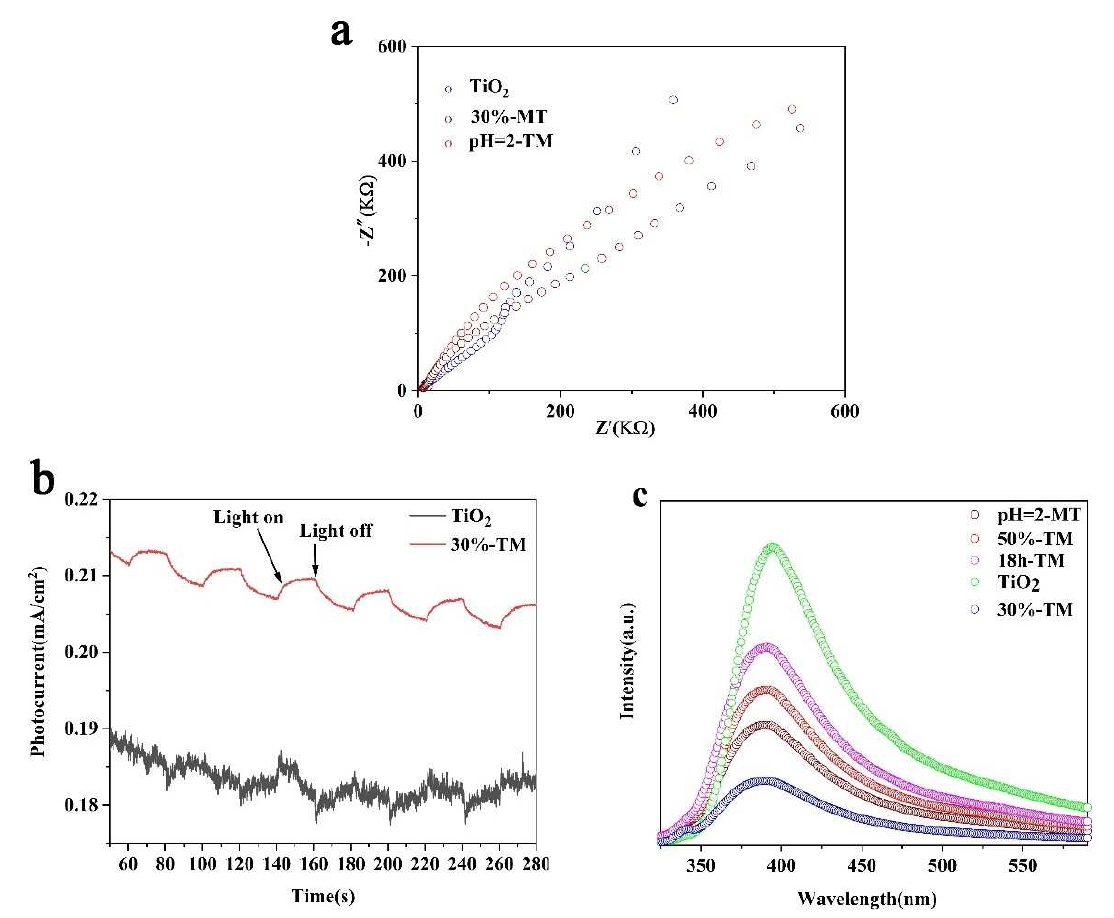
Figure 15. ( a ) EIS Nyquist plots of TiO 2 , 30%-MT, and pH = 2-MT. ( b ) Transient photocurrent re- sponses of TiO 2 and 30%-MT. ( c ) Analysis of PL of TiO 2 , 30%-MT, pH = 2-MT, 50%-TM, and 18